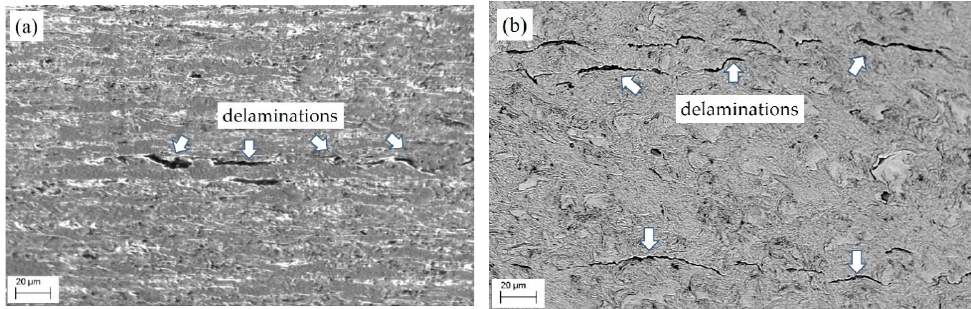
Figure 4. SEM microstructure of the LTO steel cut from ( a ) the upper part of the pipe (position T in Figure 1a) and ( b ) its lower part (position B in Figure 1a) close to its inner surface (zones II and III in Figure 1a). Delaminations are indicated by arrows.